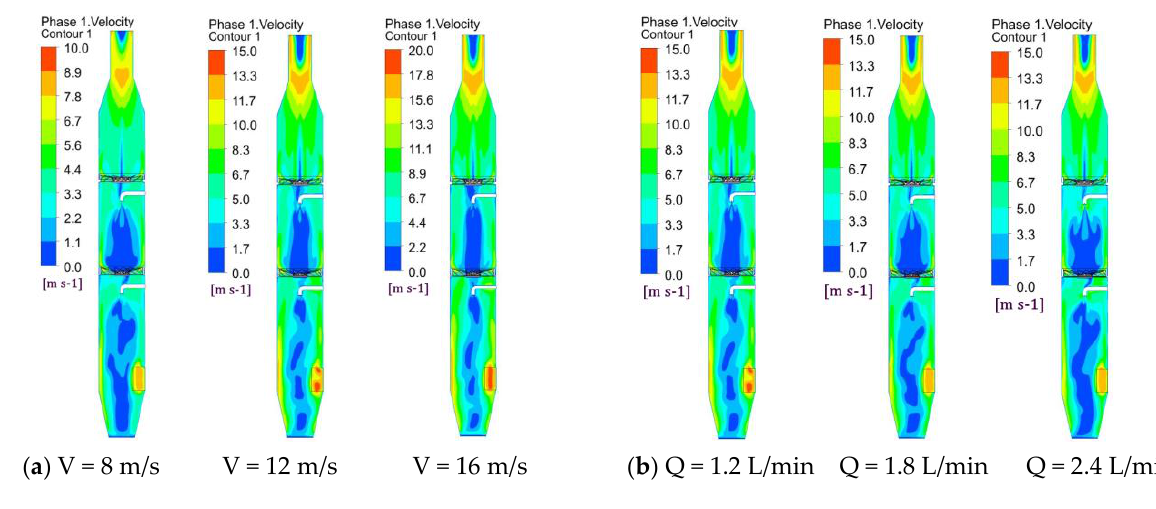
Figure 2. Cloud diagram of the airflow velocity distribution in section Y = 0 for ( a ) different gas velocities and ( b ) different spray volumes.